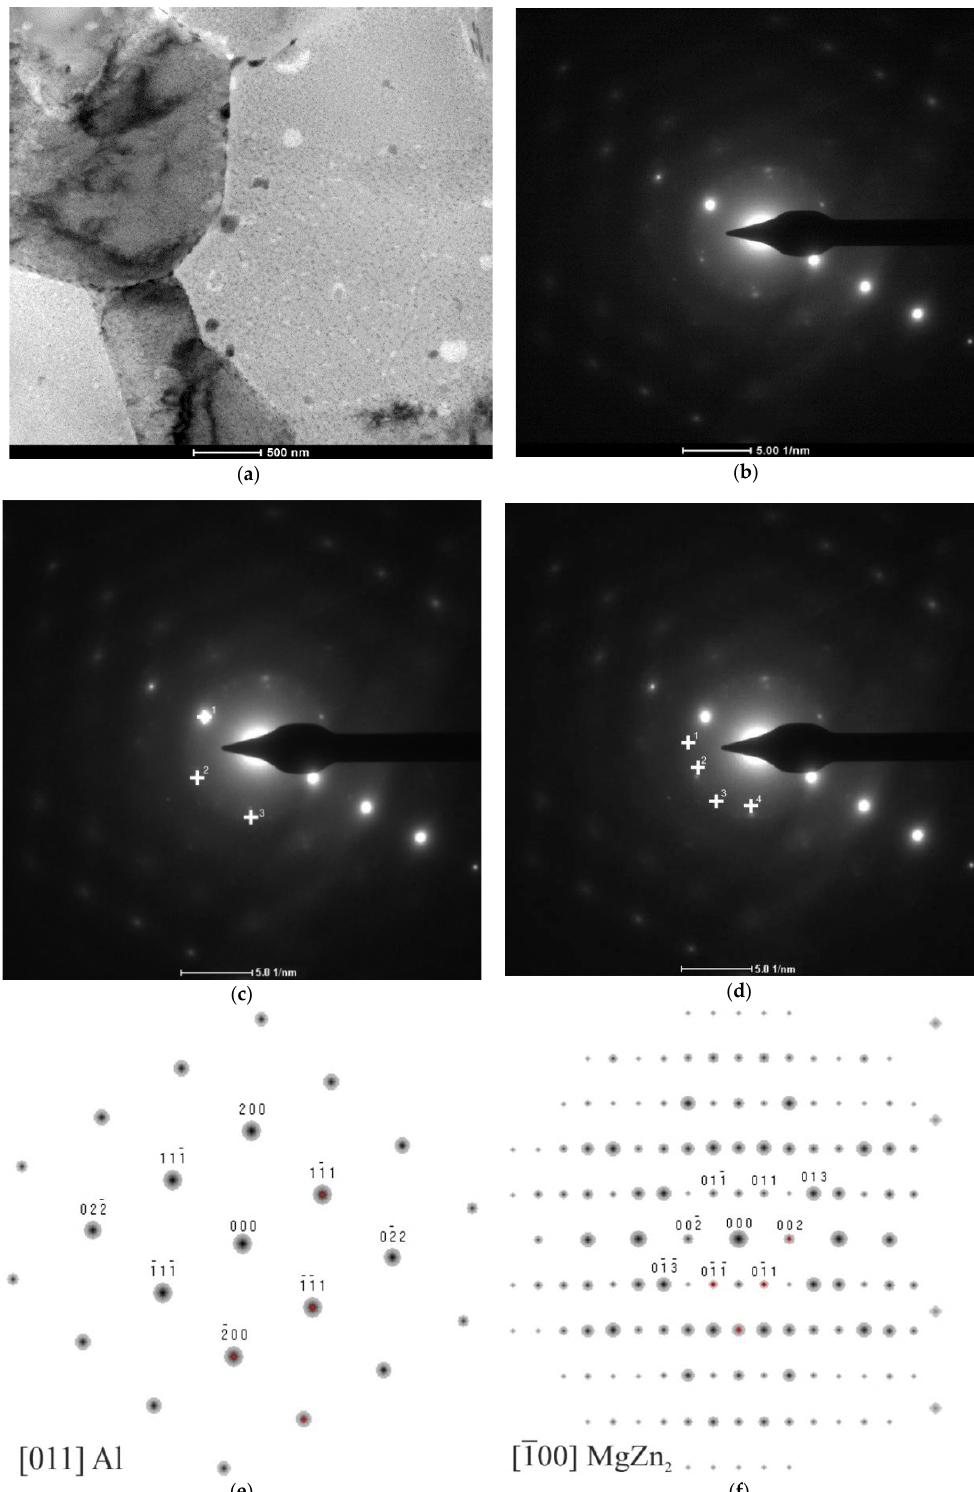
Figure 5. ( a ) Subgrains of α solution of the alloy with a high density of dislocations ; ( b ) An irregular precipitate inside the α solution subgrain.